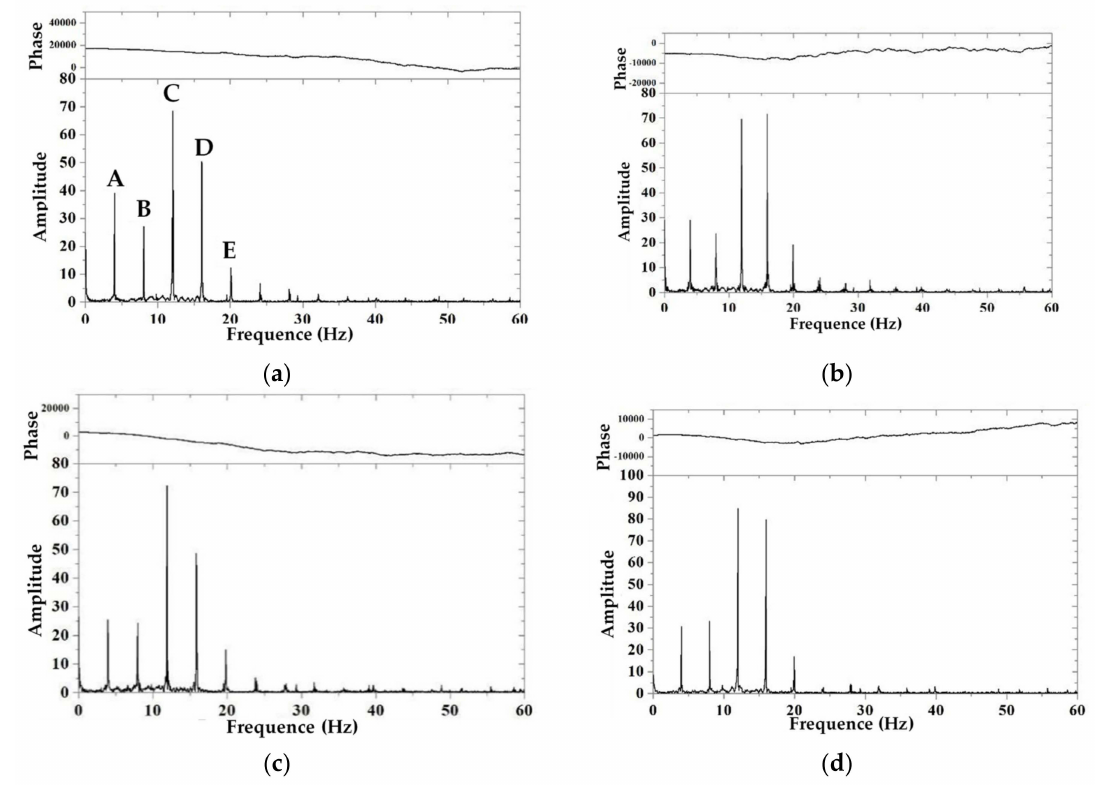
Figure 10. Spectrograms of vibration signals under four various terrain conditions. ( a ) Straight working condition. ( b ) Horizontal bending condition. ( c ) Vertical bending condition. ( d ) Combined working condition of horizontal and vertical bending.